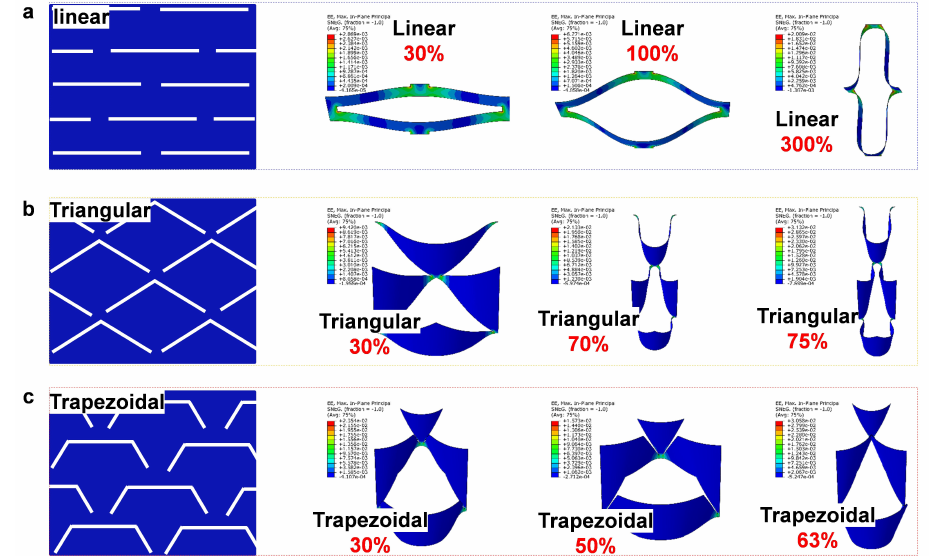
Figure 5. Design optimization of the structure, with white represents the cutting slit and blue represents the substrate: ( a ) Linear structure with tensile strain of 30%, 100%, and 300%. ( b ) Triangular shape with tensile strain of 30%, 70%, and 75%. ( c ) Trapezoidal structure with tensile strain of 30%, 50%, and